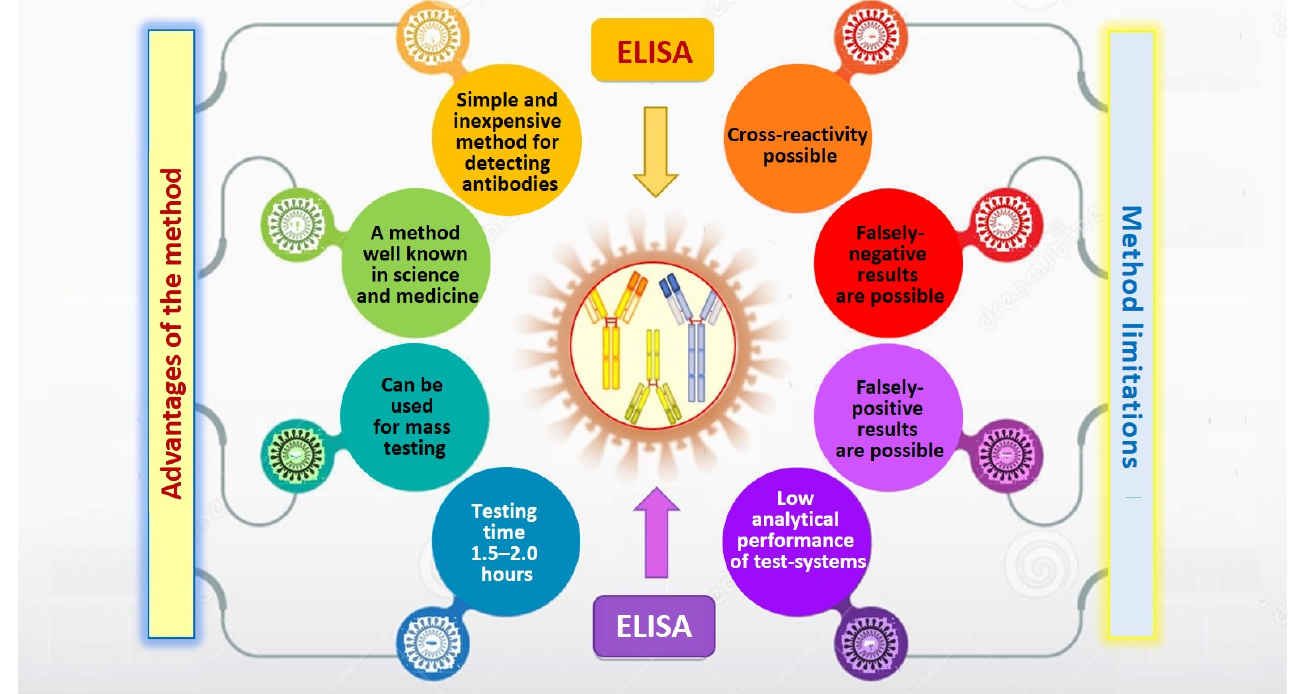
Figure 2. Advantages and limitations of the enzyme-linked immunosorbent assay (ELISA).